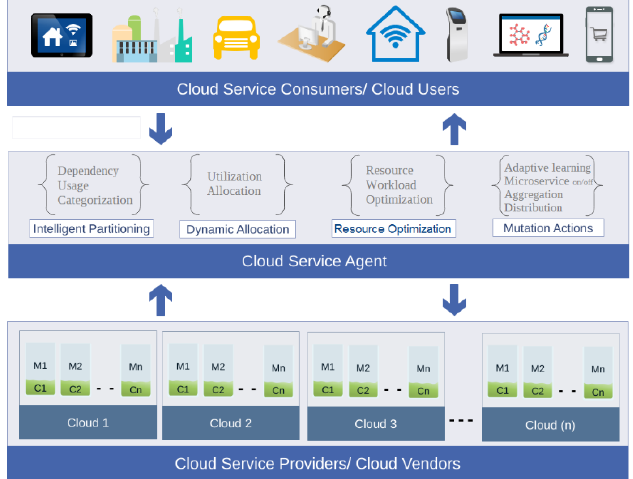
Figure 8. Layered representation of the proposed framework.